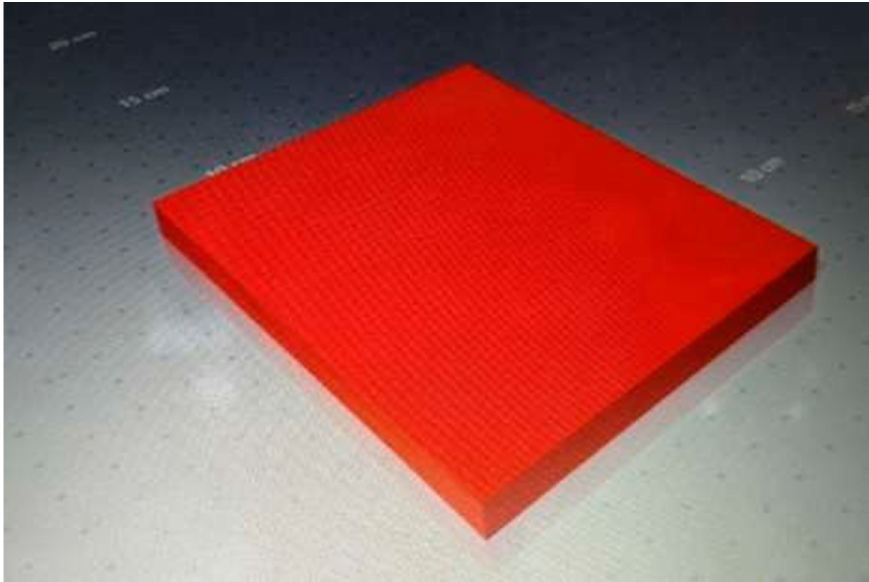
Figure 1. Sample design (10 × 12 × 1 mm 3 ) made in TinkerCAD software.